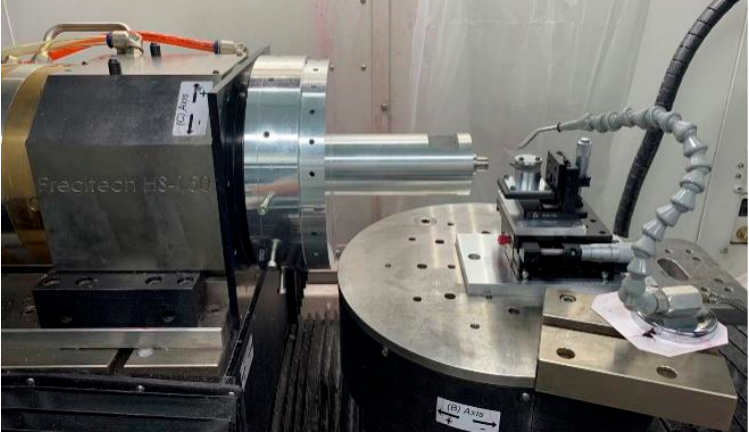
Figure 8. Ultra-precision machining machine